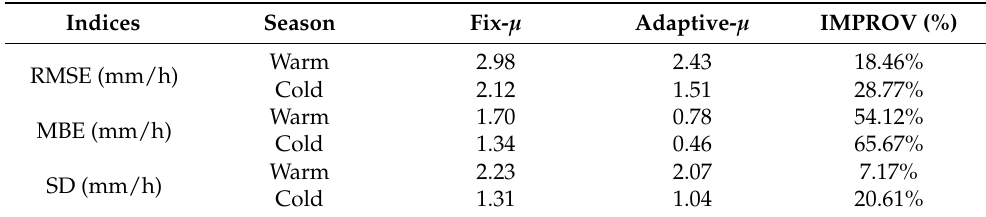
Table 3. Comparison of the fixed- and adaptive- µ model results in terms of RMSE, MBE, and SD indices for different seasons under the Morrison scheme.